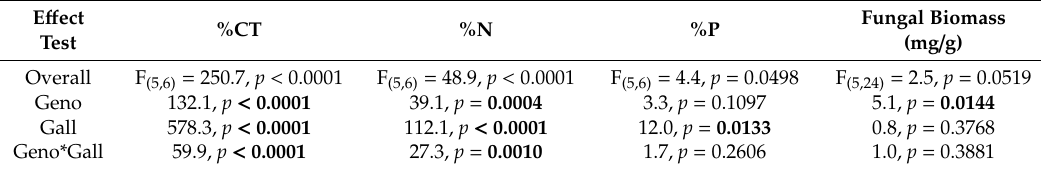
Table 2. Two-way ANOVA results for initial leaf chemistry and fungal biomass measurements at Harvest 1. Values represent overall F (df1,df2) -ratios and p -values as well as e ff ect test F -ratios and p -values for each main e ff ect (Genotype, Gall status), and the Genotype*Gall interaction. Significant e ff ects are shown in